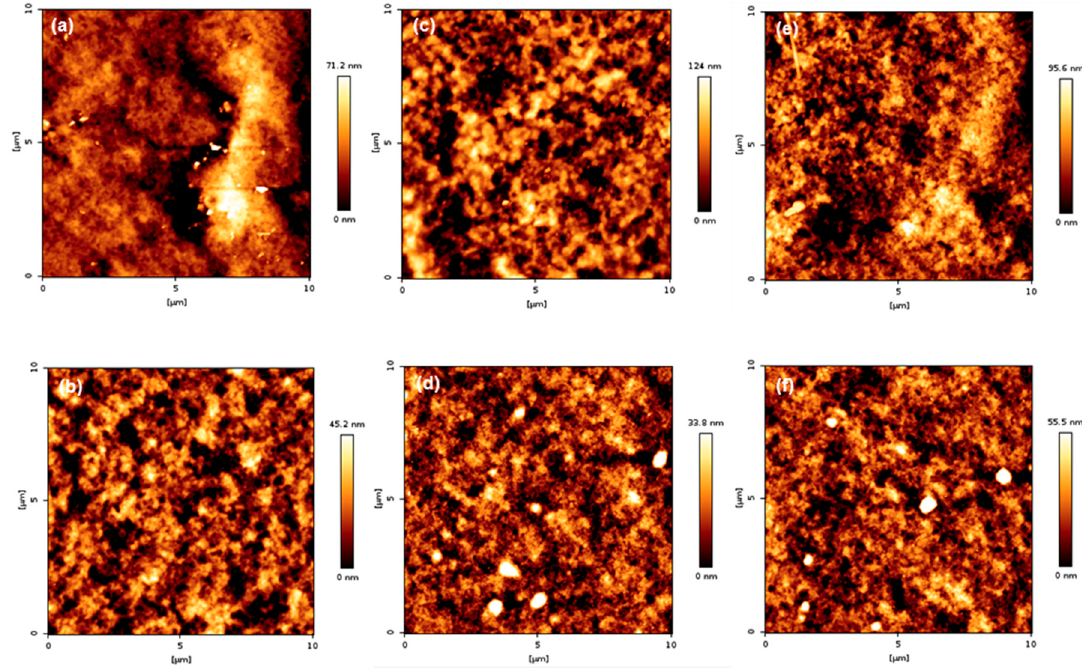
Figure 12. AFM height images of the TCR series + CF nanocomposite samples: ( a ) TCR-1 + CF, ( b ) TCR-2 + CF, ( c ) TCR-3 + CF, ( d ) TCR-4 + CF, ( e ) TCR-5 + CF, and ( f ) TCR-6 + CF.